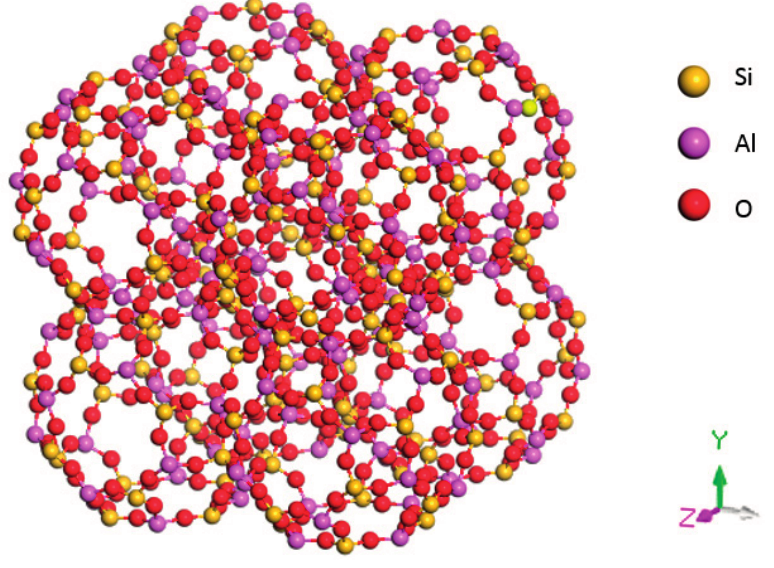
Figure 3. Structural model of an A-type molecular sieve.